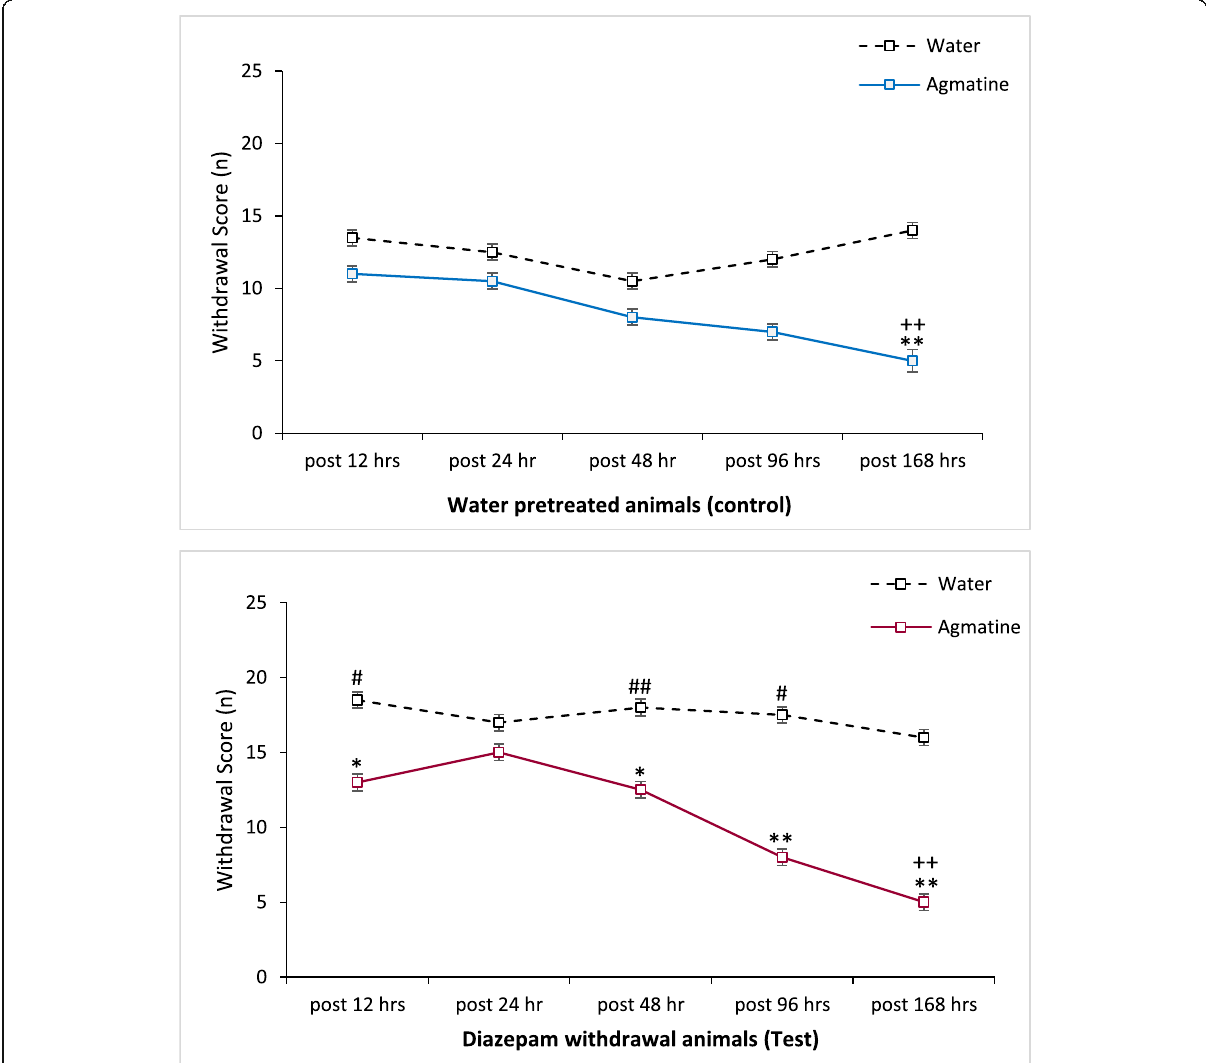
Fig. 4 Withdrawal symptoms score: Values are expressed as means ± SD (n = 12). Significant differences by Newman-Keuls test: ** p < 0.01, * p < 0.05 from control group to agmatine-treated groups. ++ p < 0.01, + p < 0.05 from the 1st day administration of water and agmatine. ## p < 0.01, #